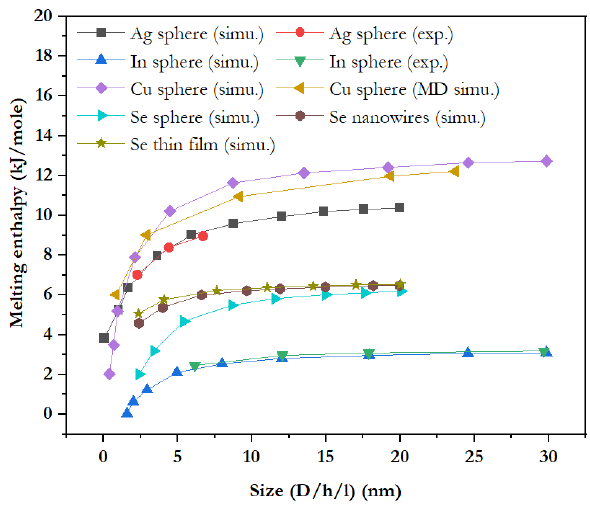
Figure 7. Shape and size dependent melting enthalpy of Ag, In, Cu and Se [32]. Chung et al. [39] reported the effect of the oxidation on the enthalpy of Al particle size by model simulation. They included the cohesive energy from the reactant particles, product lattice energy, surface capping effects, and extent of product agglomeration with variation of particle size. The strongest effects can easily be noticed from below 10 nm Al particle size. They observed that more energy was released from agglomerated oxide product as compared to the energy release from the nanoscale oxide products. Huang et